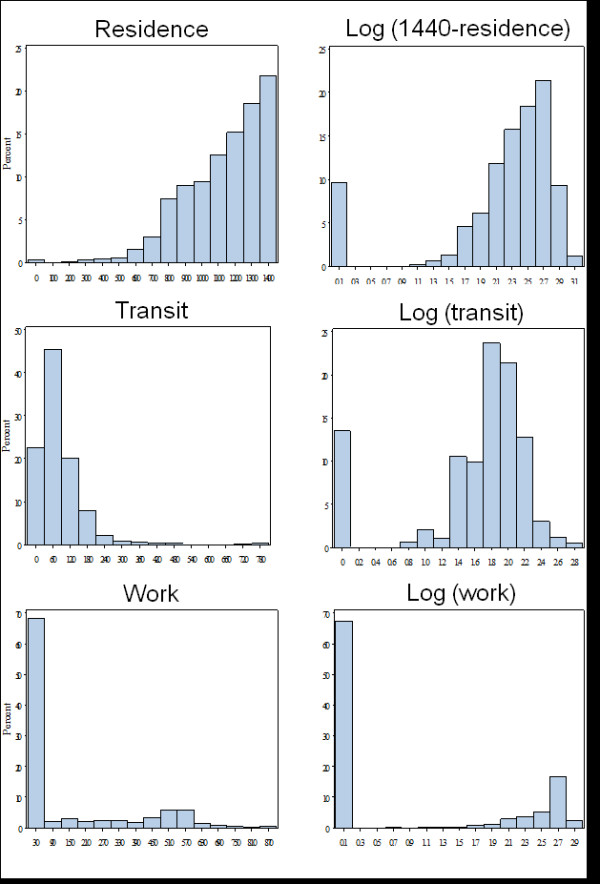
Examples of the distribution and transformation of time-location/activity data (Time spent at a residence, in transit and at work in original and log-transformed distribution).